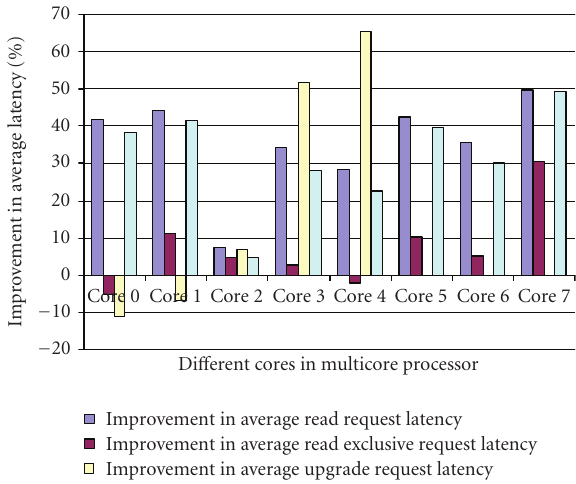
Figure 23: Improvement in average latency for di ff erent type of L2 cache requests-OCEAN.